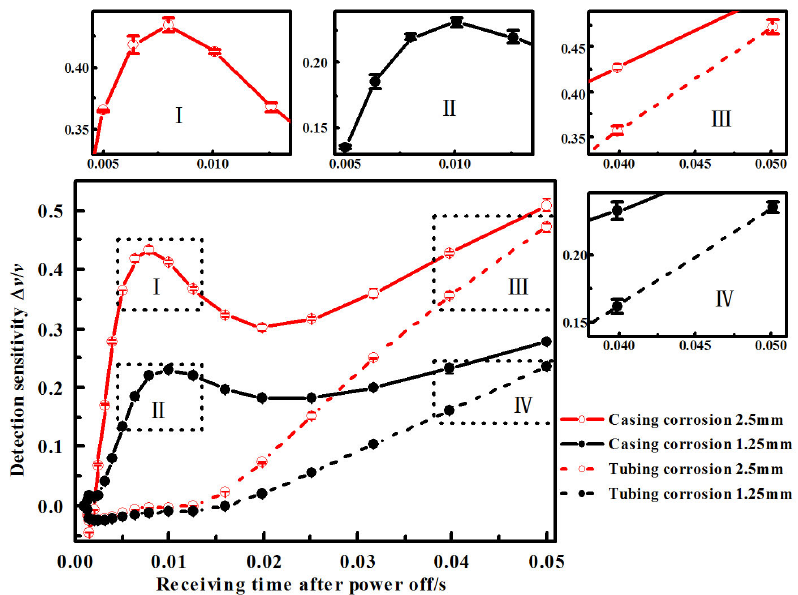
Figure 12. Sensitivity time slice curves for corrosion at different depth in the experiments.( The small graphs with Roman numerals are enlarged graphs of the corresponding part of the main graph)